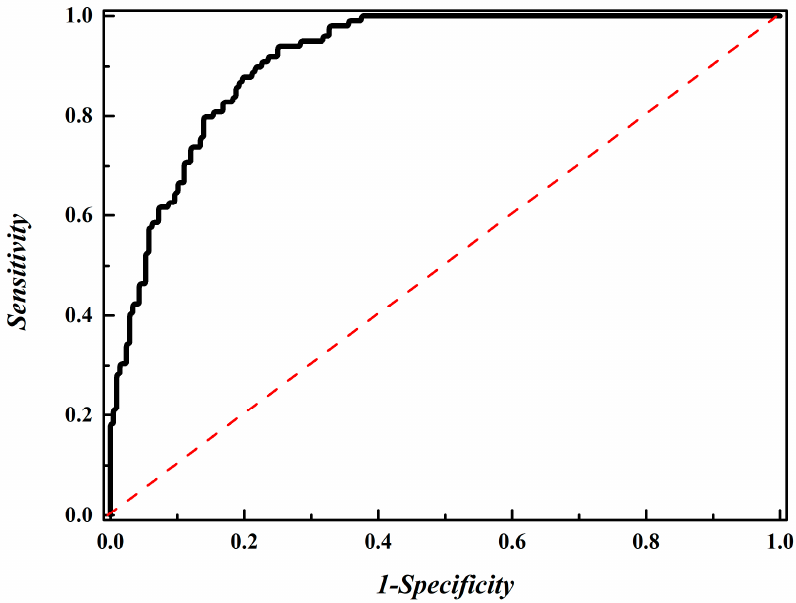
Figure 5. The ROC curve for the prediction of phage virion proteins by using 368 optimal features.